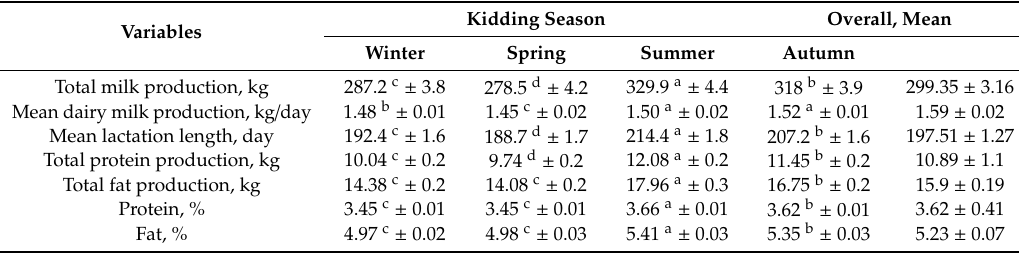
Table 5. Least square means for studied variables across the di ff erent levels of parity season